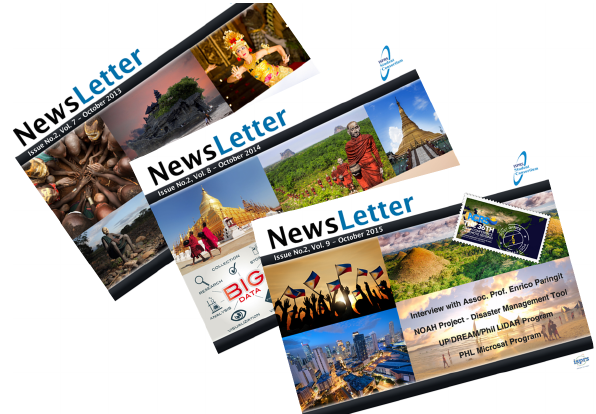
Figure 11. Various cover designs of the SC Newsletter that were distributed at summer